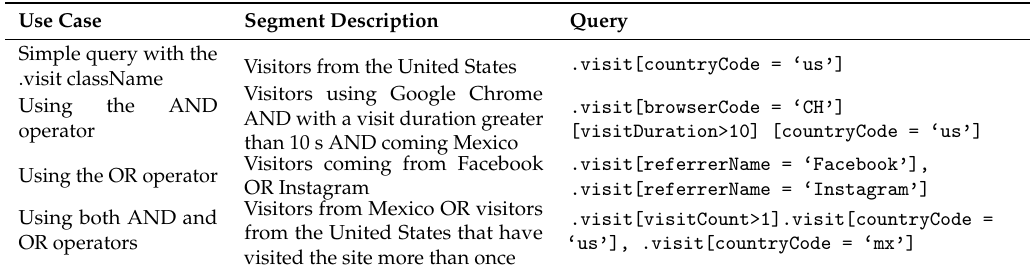
Table 4. Query examples to filter visualization visit